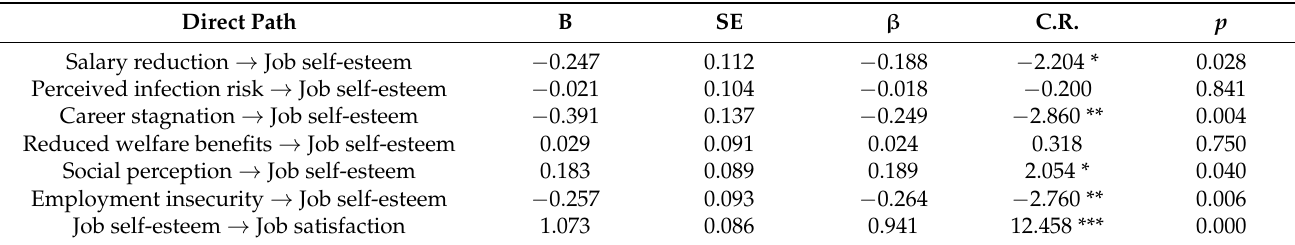
Table 8. Direct effects analysis result.